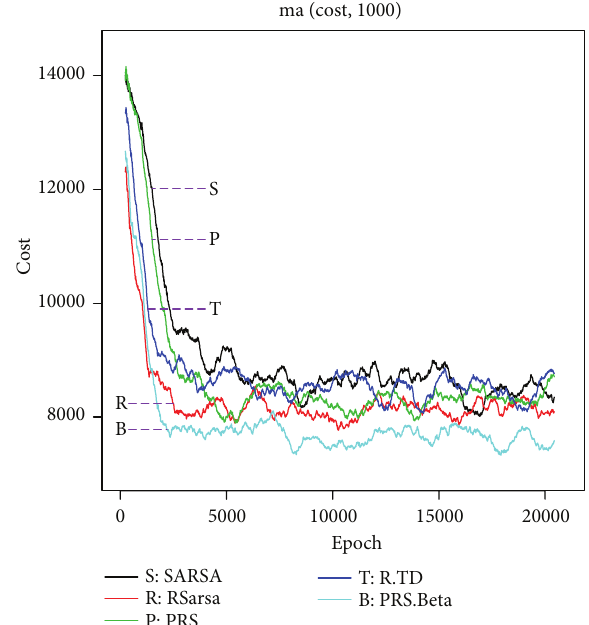
Figure 6: Moving average of period costs,